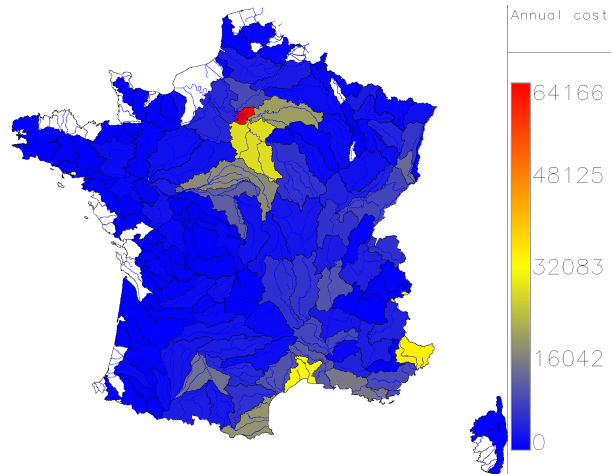
Fig. 5. The color of the areas correspond to the current expected annual losses, indicating the importance of each area. The loss-ratio assumption is based on the Var event